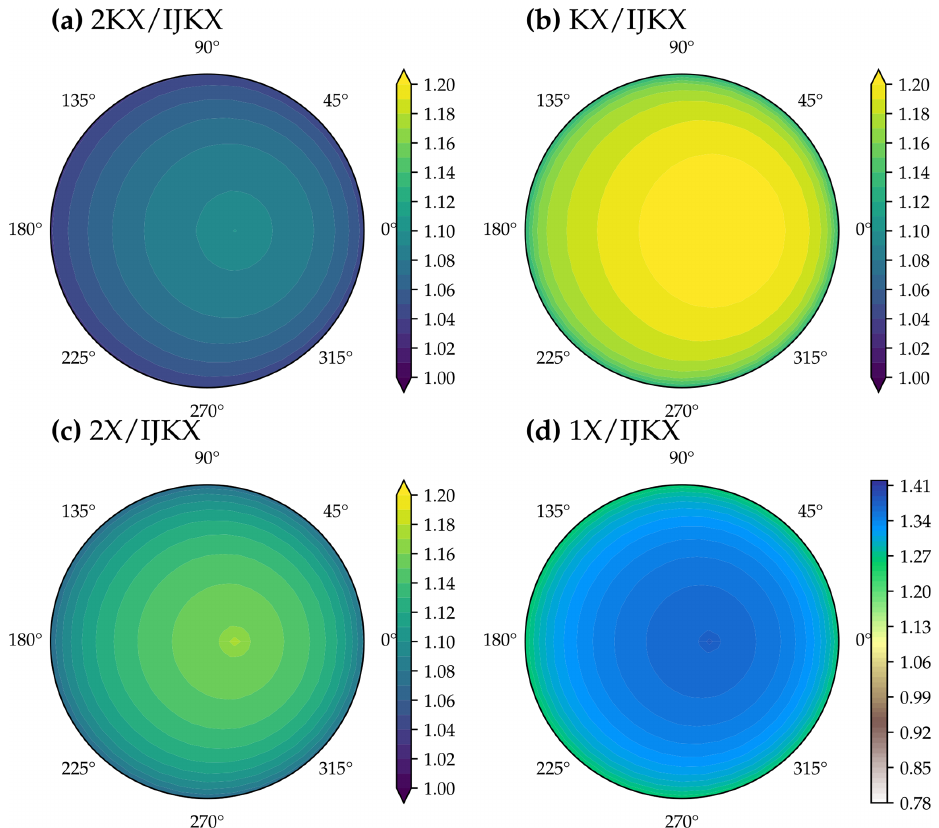
Figure 9. Difference between five different canopy complexity levels in modeled solar-induced chlorophyll fluorescence (SIF) at a different viewing zenith angle and relative azimuth angle. The color indicates SIF at 740nm of a tested canopy complexity level relative to IJKX. The model simulations were run with a profile of vertical leaf photosynthetic capacity using observed weather drivers at 12:00–12:30 of day 177 in the year 2019 at a flux tower at Ozark, Missouri, USA